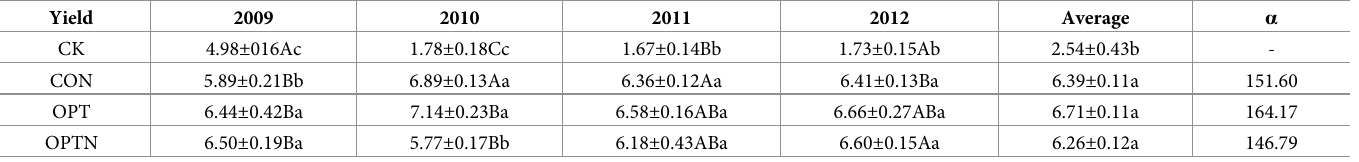
Table 5. Cotton yield in different years under different treatments (t hm -2 ).